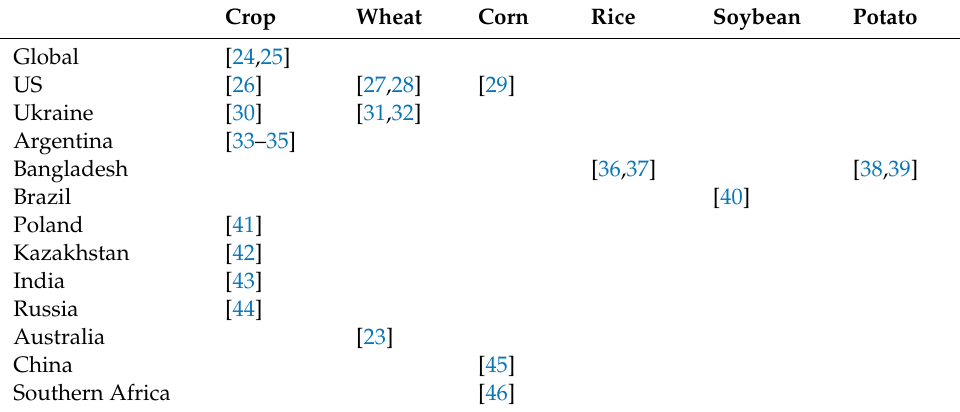
Table 1. Applications to utilize vegetation health product for estimating crop yield. Crop Wheat Corn Rice Soybean Potato